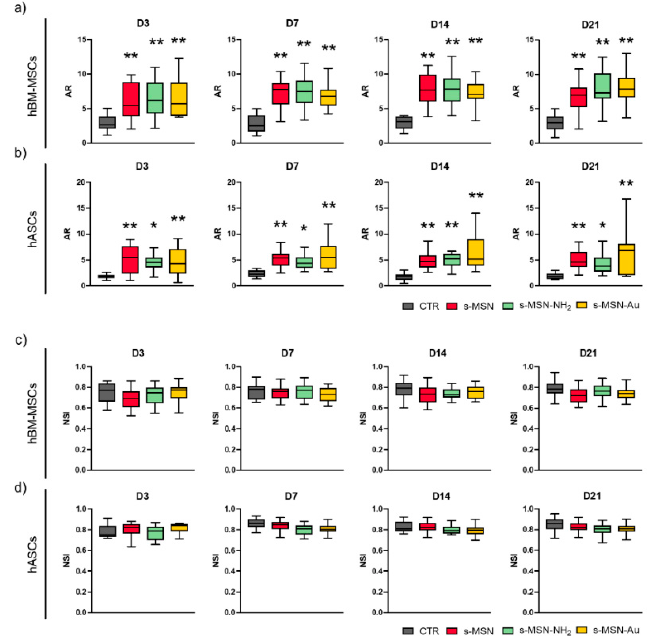
Figure 8. Morphometric measurements of stem cells on NPs deposition.s ( a , b ) Aspect ratio (AR) of hBM-MSCs ( a ) and hASCs ( b ) cultured on CTR and s-MSN, s-MSN-NH 2 , and s-MSN-Au. ( c , d ) Nu- clear Shape Index (NSI) of hBM-MSCs ( c ) and hASCs ( d ) cultured on CTR and s-MSN, s-MSN-NH 2 , and s-MSN-Au. Results are expressed as mean ± SEM. * p < 0.05, ** p <